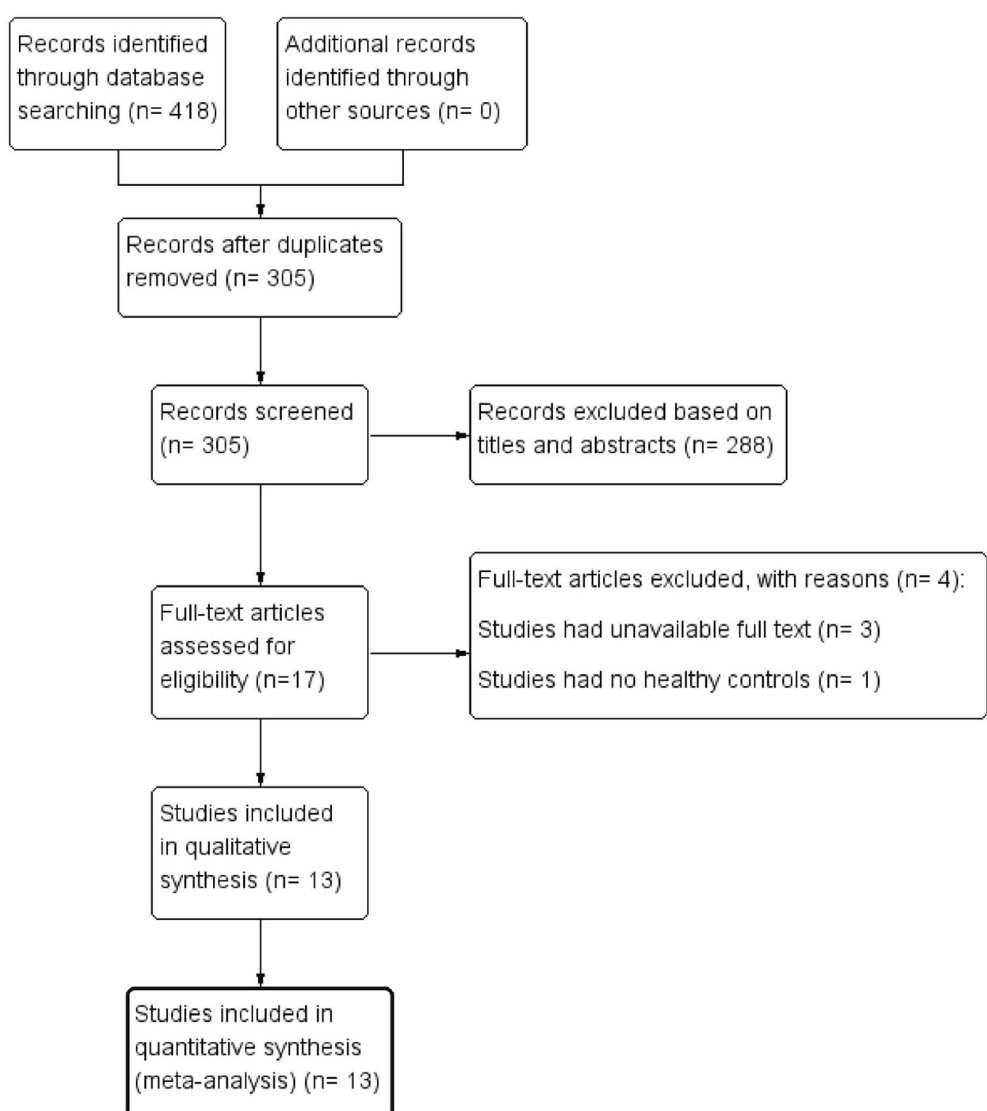
Figure 1. Flow diagram of study selection in the